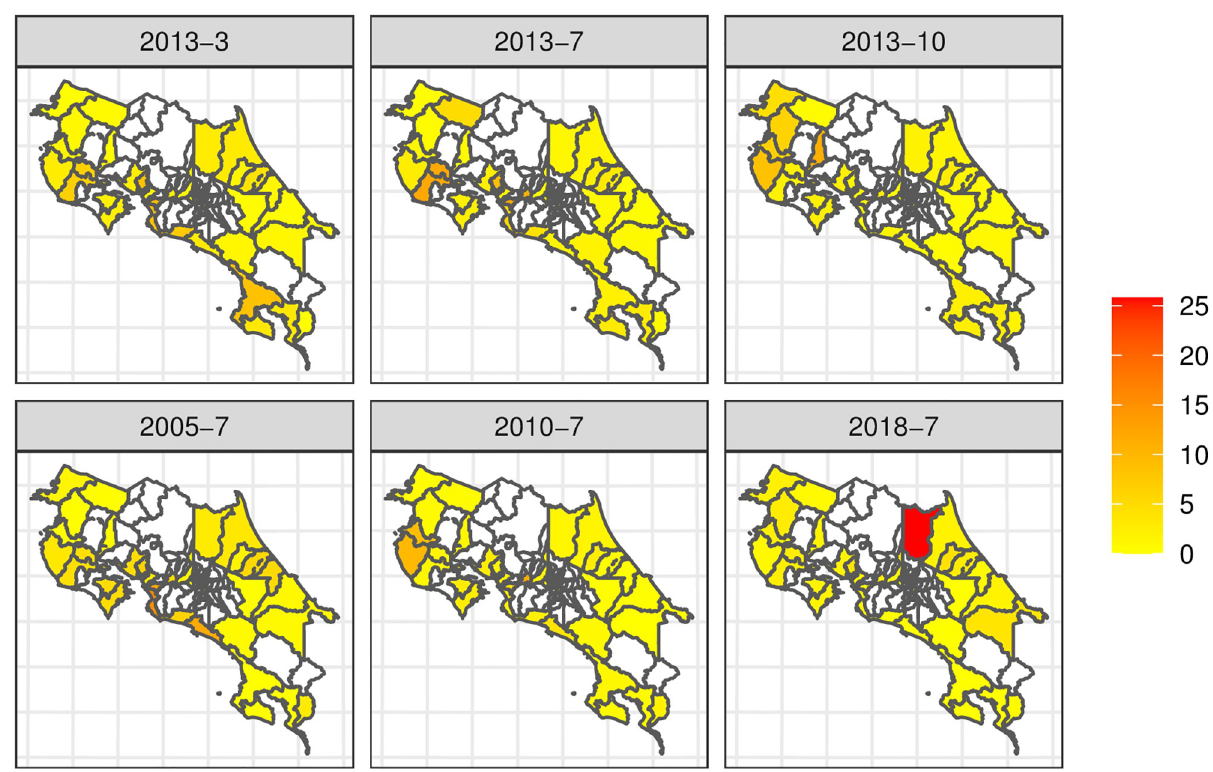
Fig 1. The Relative Risk ( RR ) over the 32 cantons in the study for different months and years of available data. We show three months for 2013 (top panels) and July for three different years (bottom panels). The map was created using R software (shapefile found here: https://hub.arcgis.com/ datasets/741bdd9fa2ca4d8fbf1c7fe945f8c916_0/explore). The license is public